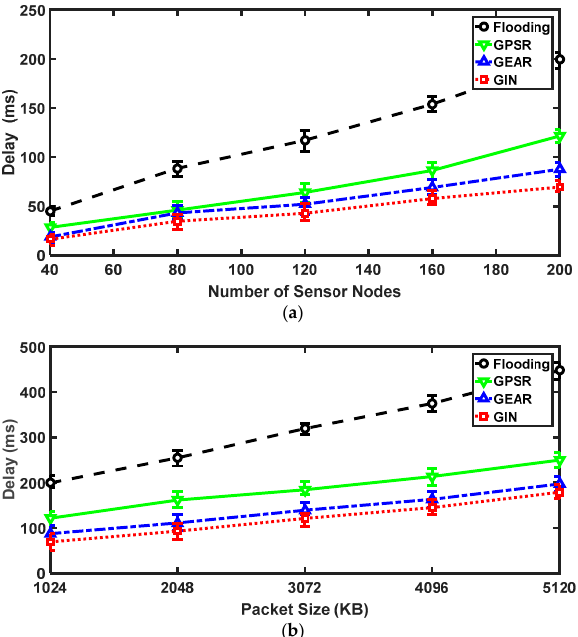
Figure 9. The results for GIN in delay. ( a ) Relationships between the delay and the number of nodes; ( b ) Relationships between the delay and the packet size. Sensors 2018 , 18 , x FOR PEER REVIEW For the packet loss ratio, it is related to the packet length and the transmission frequency. In terms of the packet length, there are five cases (i.e., the packet length is divided into 1000 KB, 2000 KB, 3000 KB, 4000 KB and 5000 KB). As the packet length increases, the packet loss ratio continues to deteriorate as shown in Figure 10a. Especially in the case of the flooding, the packet loss ratio increases steadily between 1000 KB and 3000 KB. However, this number is seriously higher than other protocols. After the 3000 KB line, the packet loss ratio of flooding protocol becomes worse. When the packet length is 5000 KB, the packet loss ratio approaches 0.05. At this stage, the performance of GIN in packet loss ratio is still a preferred one. The maximum packet loss ratio in GIN protocol is almost equal to that of the minimum value in flooding method, i.e., it is approximately 0.01. Moreover, the value gap of GIN and GEAR protocols is almost similar to the gap of GEAR and GPSR protocols in the packet loss ratio. The gap of them is about 0.008. Due to the IN mechanism, the GIN protocol rarely encounters the selective dropping packet attacks. Therefore, it is the safest one of the four protocols. Figure 10b illustrates that the packet loss ratio is inversely proportional to the transmission frequency of packet. When the transmission frequency of packet is 10 Mbps, the packet loss ratio of the four protocols is at their respective maximum. Between 10 Mbps and 20 Mbps, the packet loss ratio of flooding, GPSR and GEAR protocols drops significantly. After 20 Mbps, the downward trend of them tends to be smooth. Conversely, the GIN protocol begins to decline slowly and speeds up later. When the transmission frequency of packet exceeds 40 Mbps, the packet loss ratio of the GIN, GEAR and GPSR protocols is almost the same. However, the value of flooding is still higher than other protocols. In one word, the GIN protocol outperforms other three protocols in the packet loss ratio.